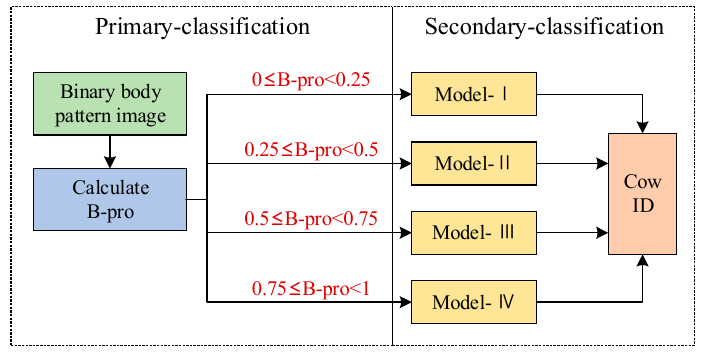
Figure 5. Cascaded classification